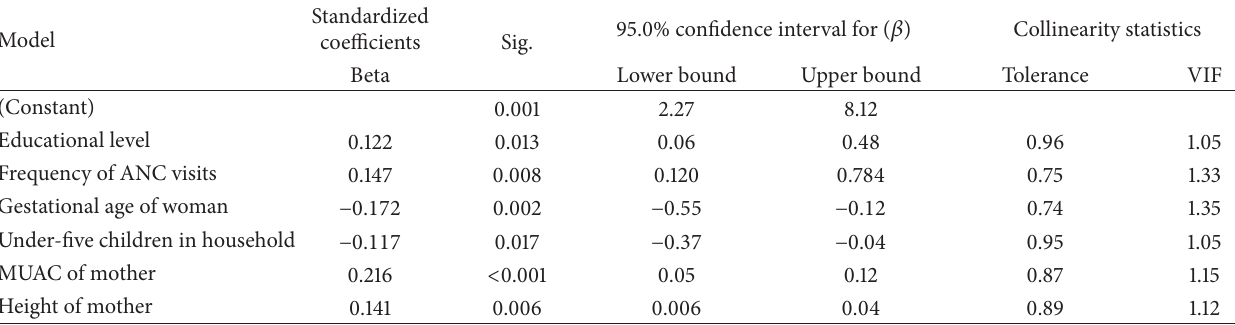
Table 4: Determinants of haemoglobin concentration (g/dl) of pregnant women (multiple linear regression analysis).